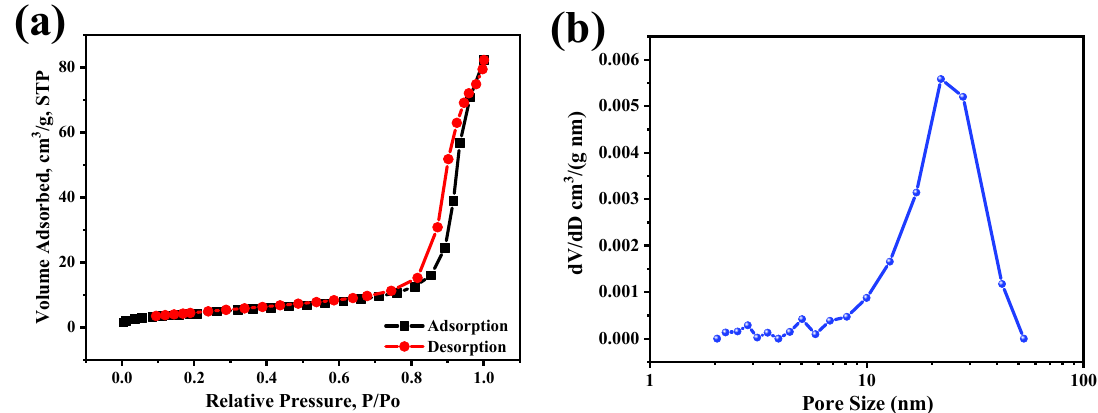
Figure 4. ( a ) N 2 adsorption/desorption isotherms of the as-dealloyed nanoporous Cu 6 Sn 5 . ( b ) The pore size distribution. CVs at a scan rate of 0.1 mV s − 1 between 0.01 and 2.5 V (vs. Li + /Li) are shown in Figure